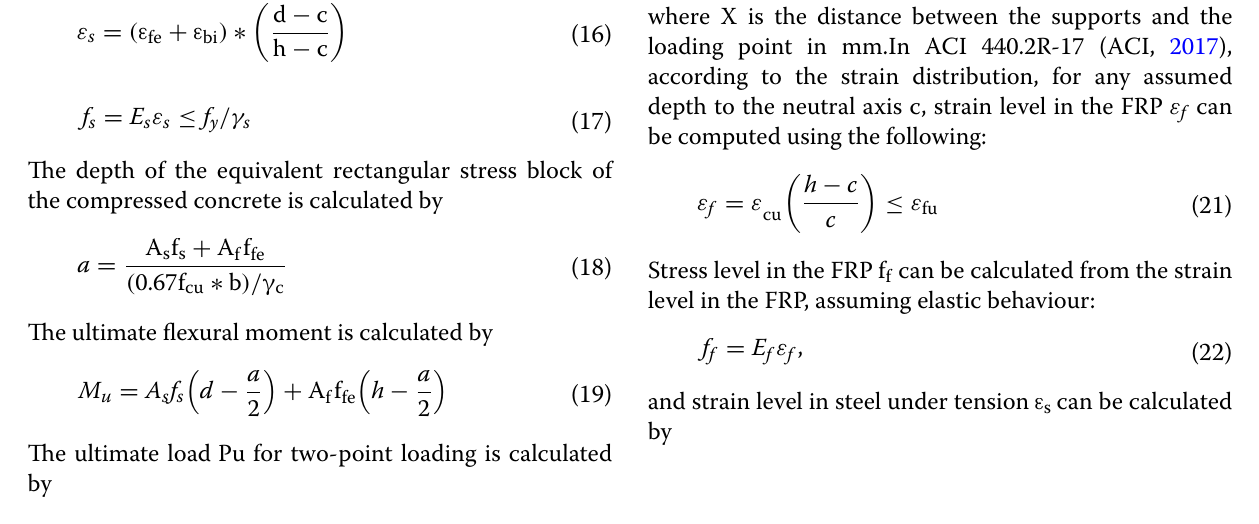
where X is the distance between the supports and the loading point in mm.In ACI 440.2R-17 (ACI, 2017), according to the strain distribution, for any assumed depth to the neutral axis c, strain level in the FRP ε f can be computed using the following: